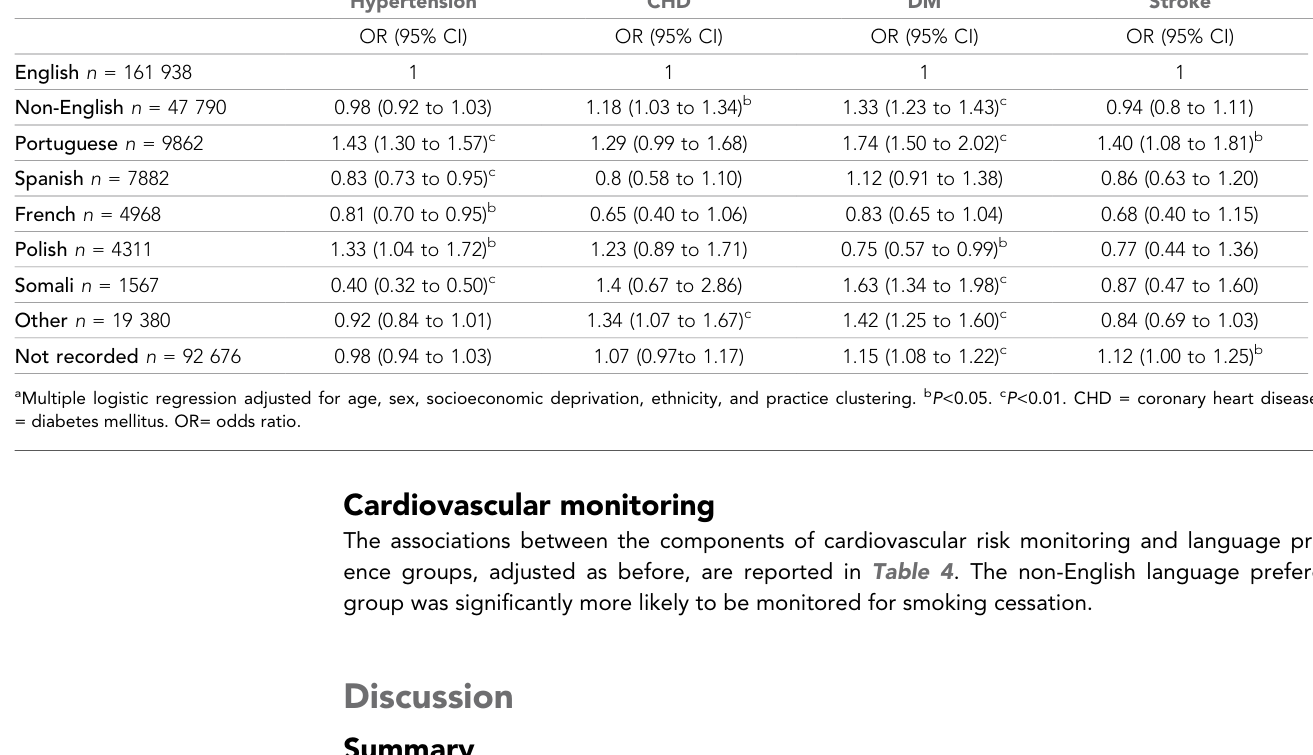
Table 2. Association between cardiovascular diagnosis and language preference (adjusted a ORs with 95% Cs). Hypertension